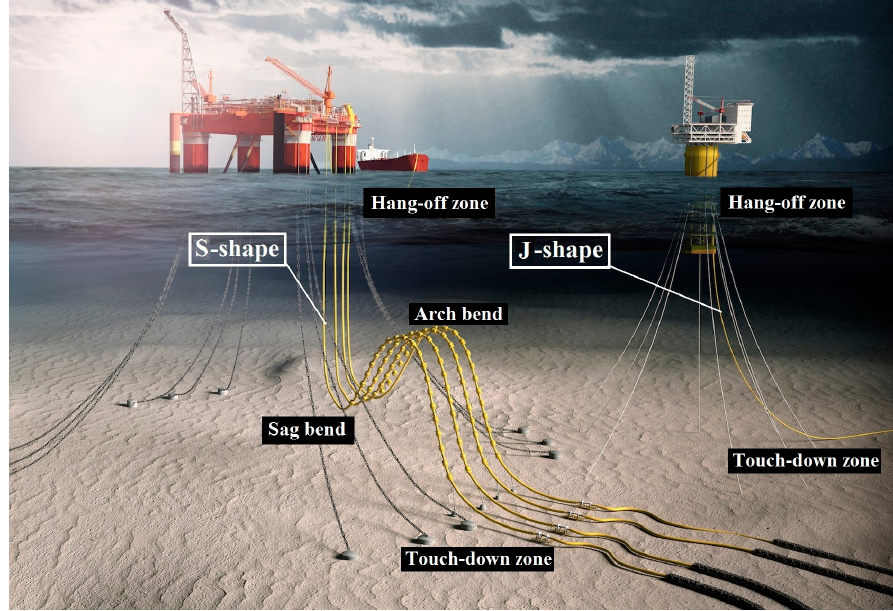
Figure 1. Fatigue critical zones in two typical offshore metallic pipes: J-shape and S-shape.